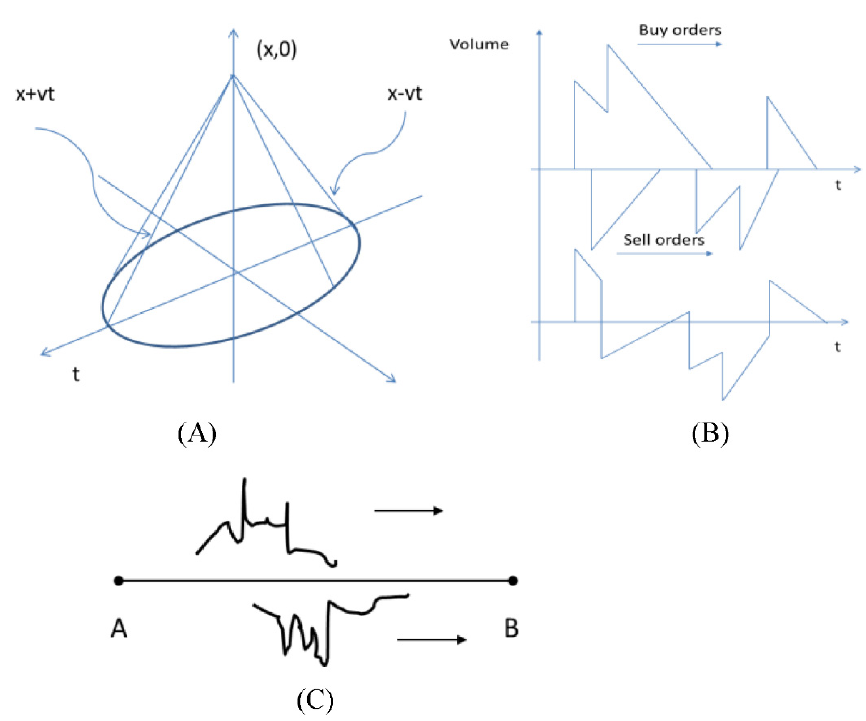
Figure 1. ( A ) Relativistic light cone. Only part x > 0 is drawn for clarity. ( B ) Schematic shape of the random signal propagating across the line. The upper axis shows “Buy” and “Sell” orders separately, and the lower axis shows the sum of the orders. The vertical axis may correspond to the number of shares traded, or to the aggregate dollar volume, depending on the organization of the trading venue and the type of order. ( C ) “Topology” of the trading network. Exchange is located at point A, and the imbalances are absorbed (cleared) at point B. Traders are distributed along the line AB, according to the Poisson law.